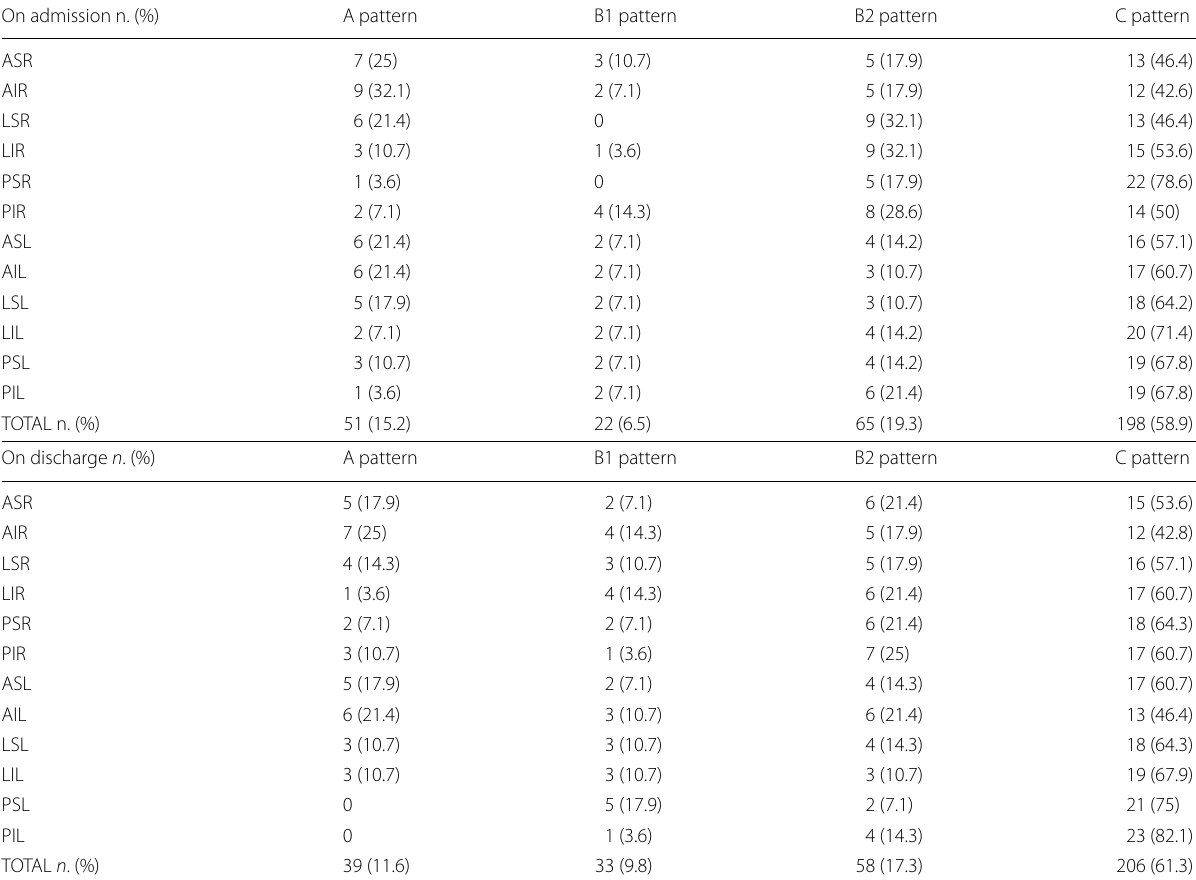
Table 2 Frequency of presentation of different lung ultrasound patterns on each investigated area on admission and discharge in COVID-19